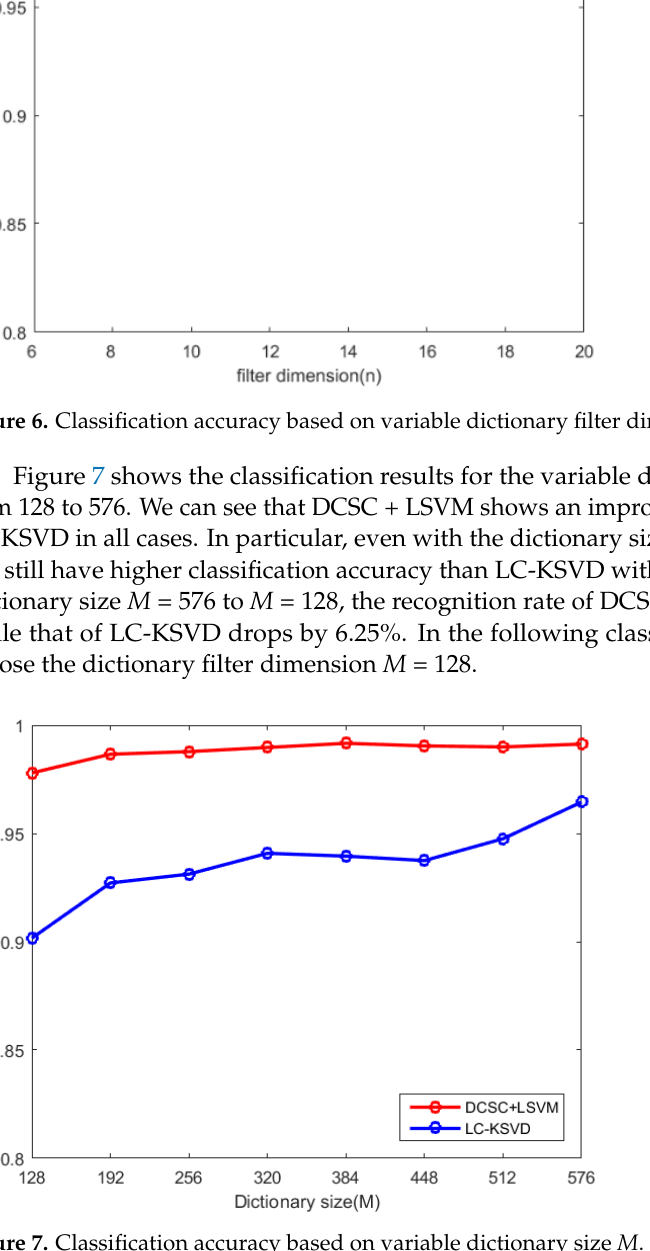
Figure 7. Classification accuracy based on variable dictionary size M .